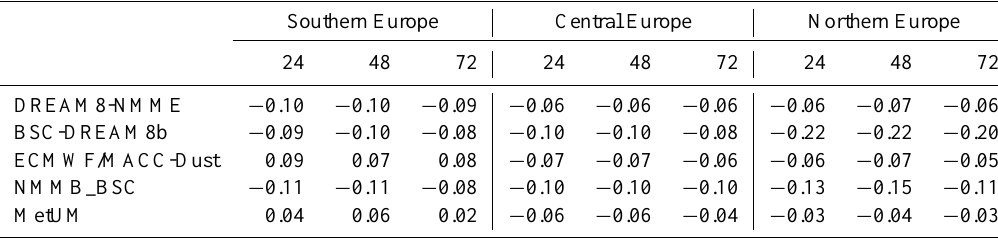
Table 3. Same as Table 2 but for mean bias (MB).